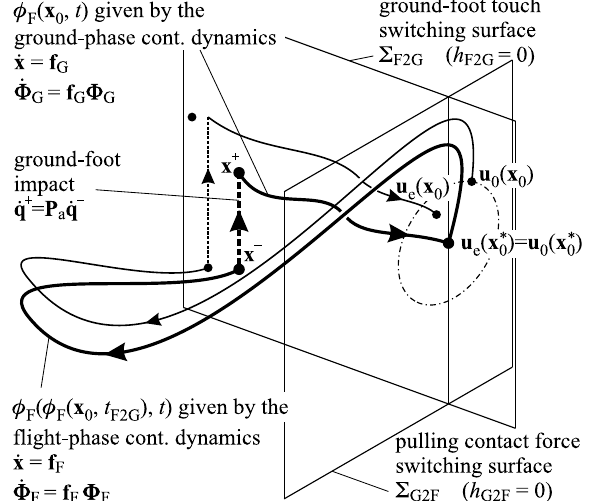
Figure 2. The periodic orbit, the perturbed motion, the switching surfaces, and the discrete mapping at F2G